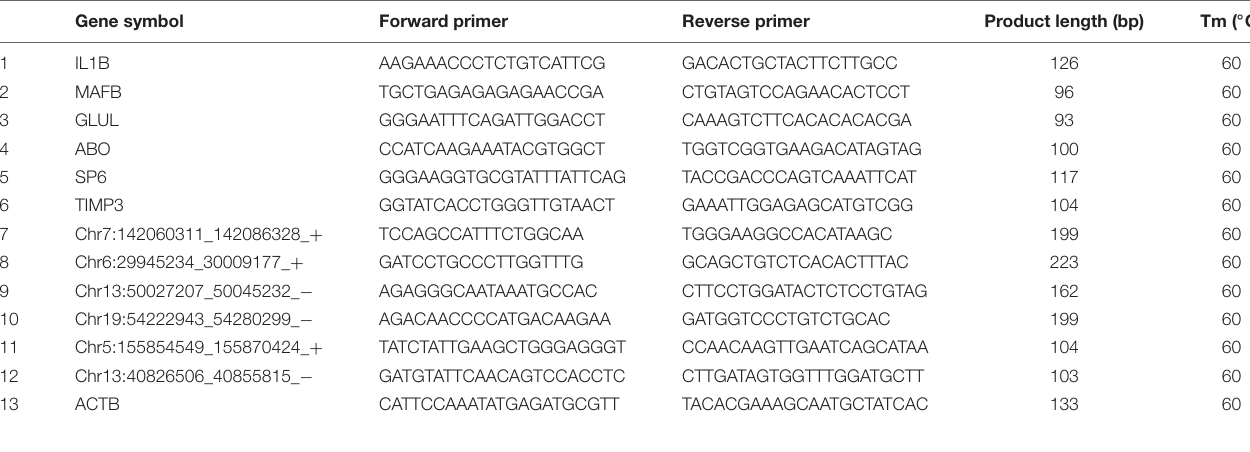
TABLE 2 | List of RNA primer sequence verified by qPCR. Gene